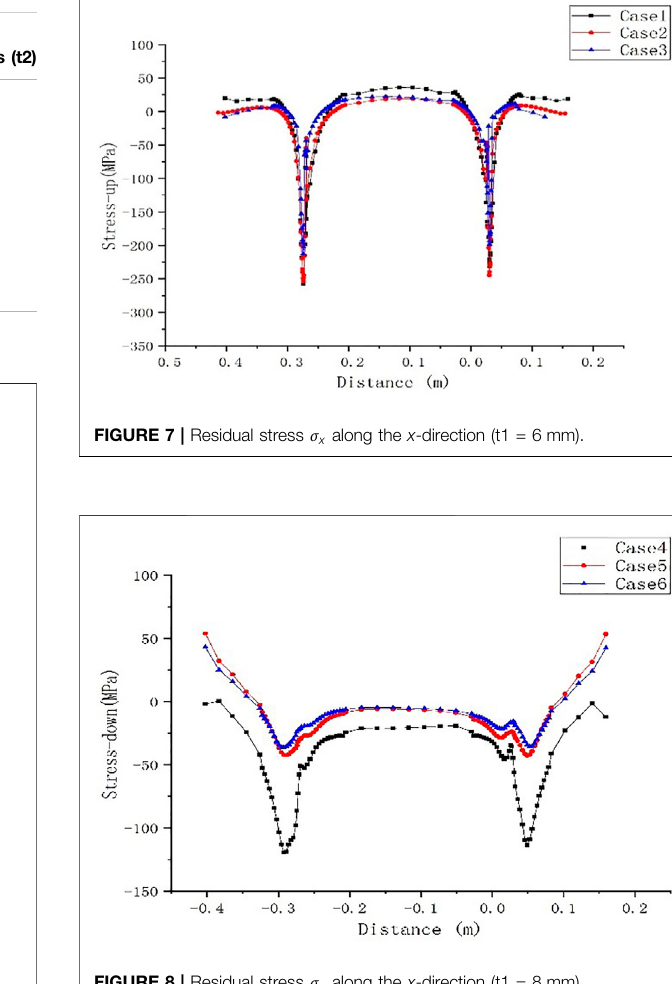
FIGURE 6 | Top view of weld lines.